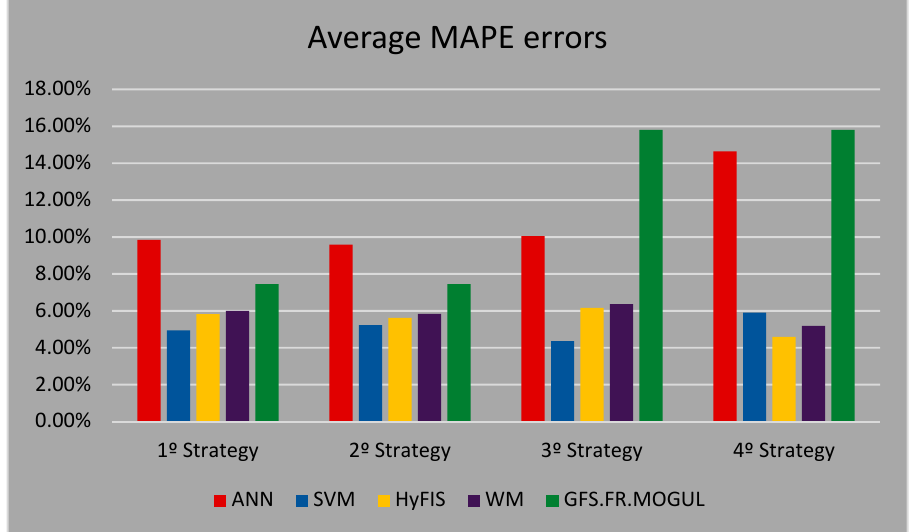
Figure 16. Average MAPE errors of the forecasting methods.